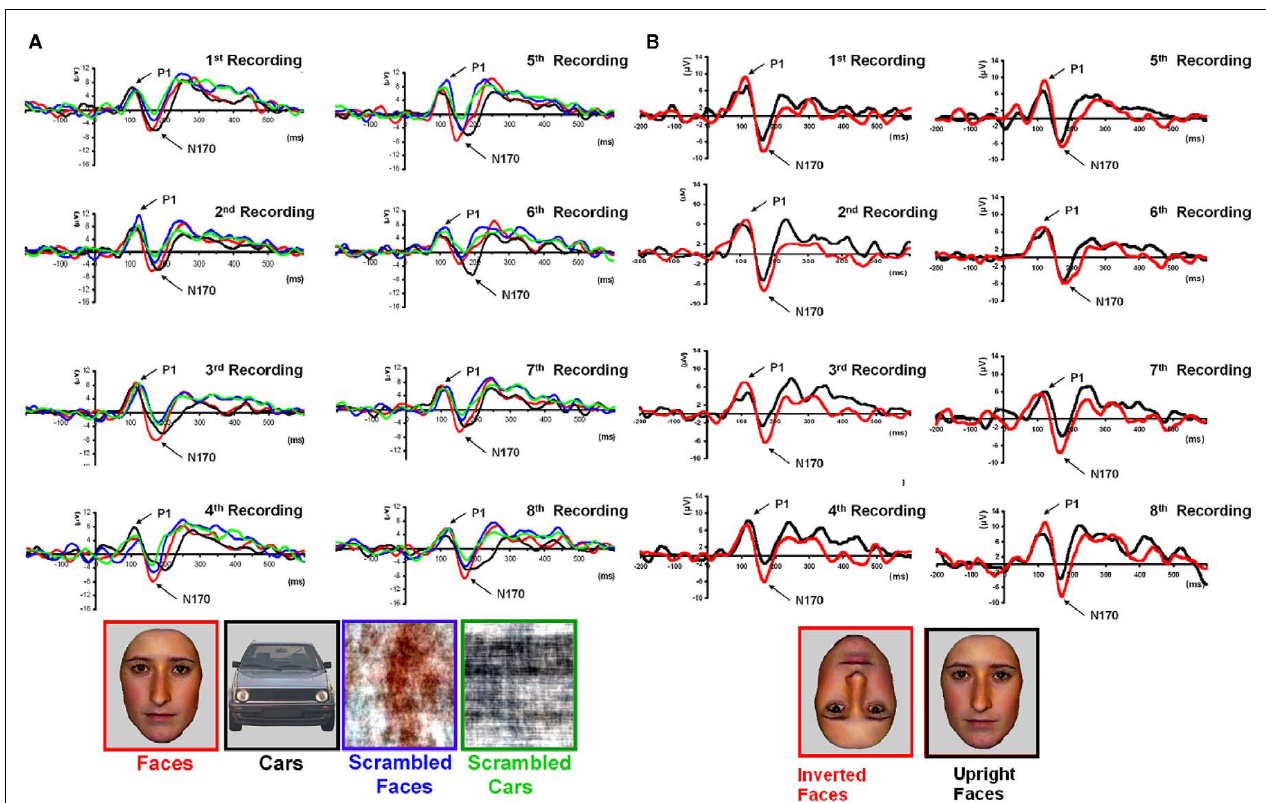
N170 in the right hemisphere can be observed. (B) . Eight recording sessions of Experiment 2, showing the latency delay and amplitude increase for inverted as compared to upright faces.The latency delay was not present in one of the recording sessions only (seventh), where the preceding component (P1) was substantially delayed for upright